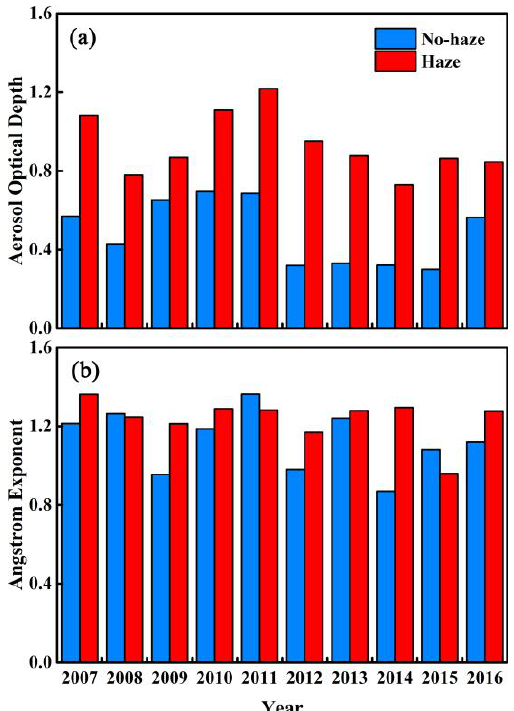
Figure 2. Time series charts of (a) AOD (500 nm) and (b) AE (440-870 nm) in 2007-2016